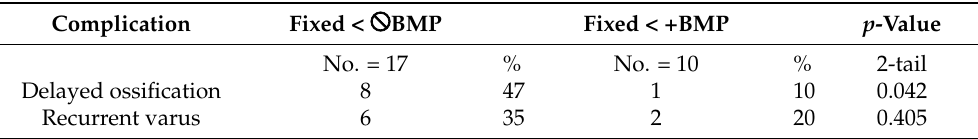
fixed angle + BMP2 (group 3). Table 5. Comparison of complications in revision SH: fixed angle + no BMP2 (group 2) vs. fixed Table 4. Comparison of complications in primary SH: non-fixed angle + no BMP2 (group 1) vs. angle + BMP (group 3).